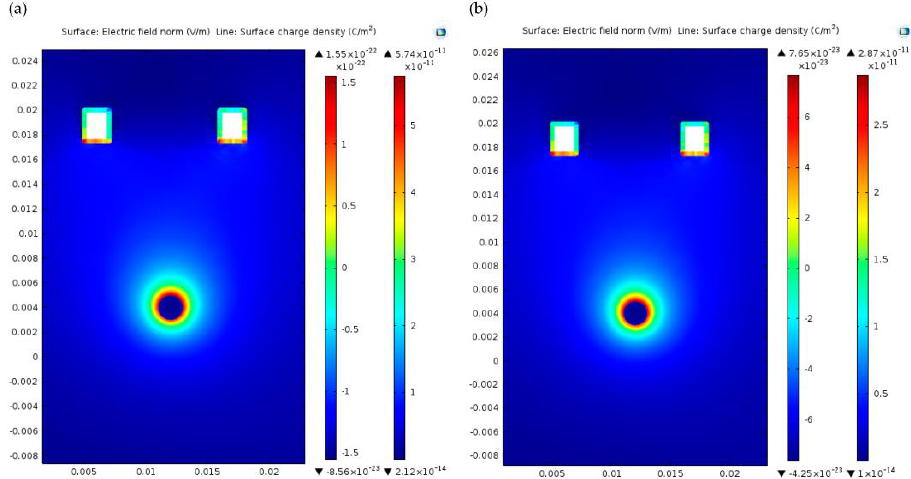
Figure 7. Comparison the electric field effect and surface charge density of the electrodes using GN-based ( a ) and conventional Ag/AgCl based electrode ( b ).